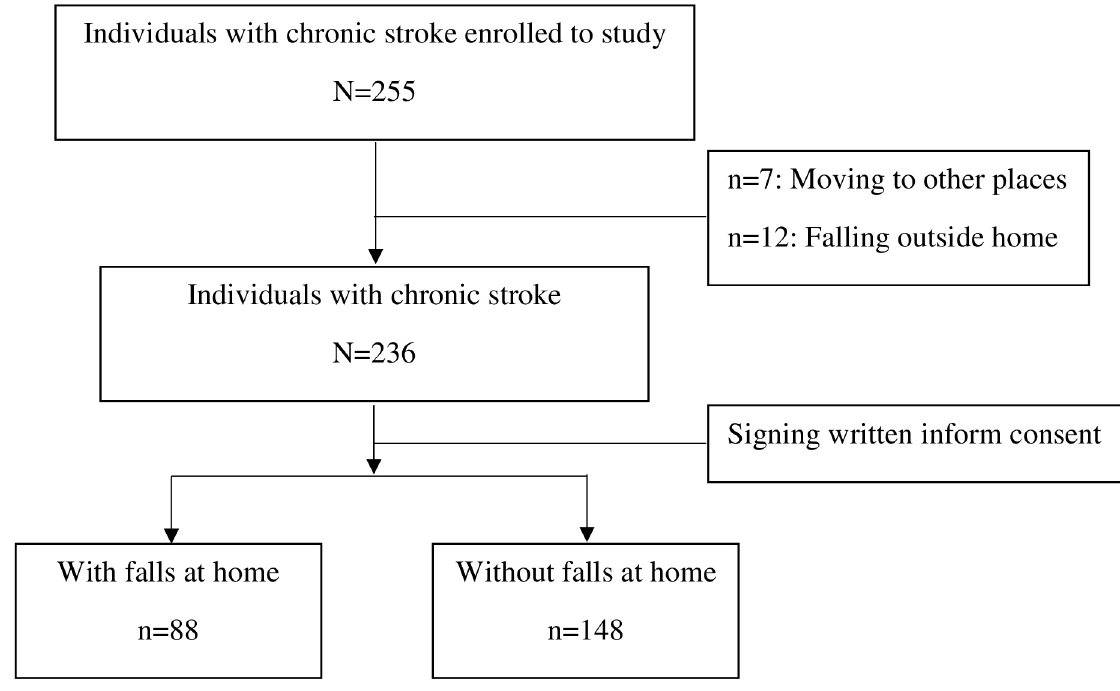
Fig 2. Flow chart of